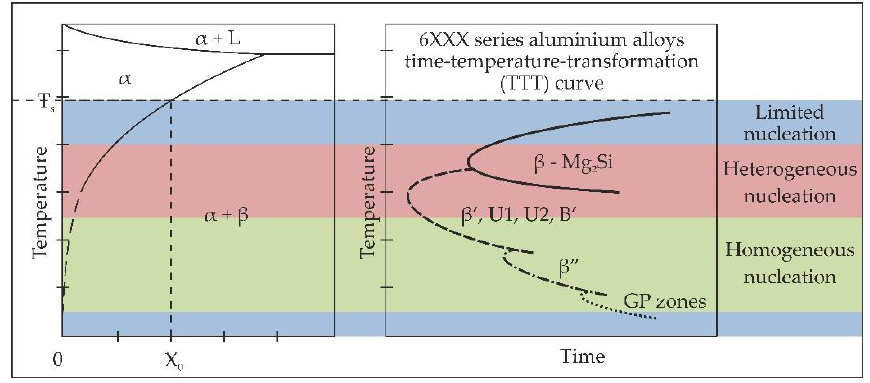
Figure 1. Scheme of the precipitation kinetics in 6xxx series alloys.